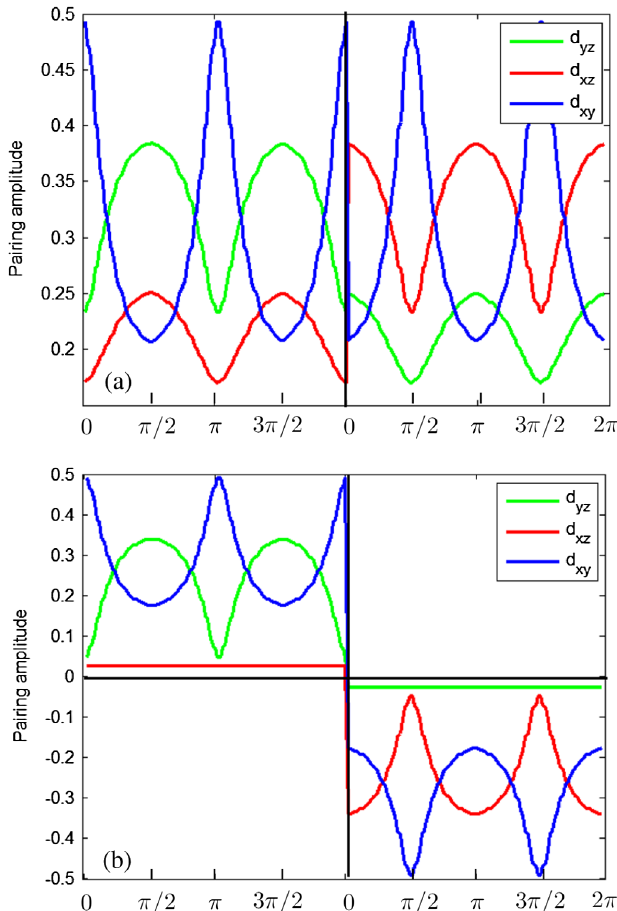
FIG. 6. The orbital-resolved pairing amplitude on the FS for a typical s -wave/ d -wave pairing state in the upper and lower panels, calculated within mean-field approximation. The inter- ¼ 0 , J ¼ 0 : 8 for the upper panel and action parameters are J 1 2 ¼ 0 : 5 , J ¼ 0 for the lower panel. The k point traces are J 1 2 defined as in Fig.